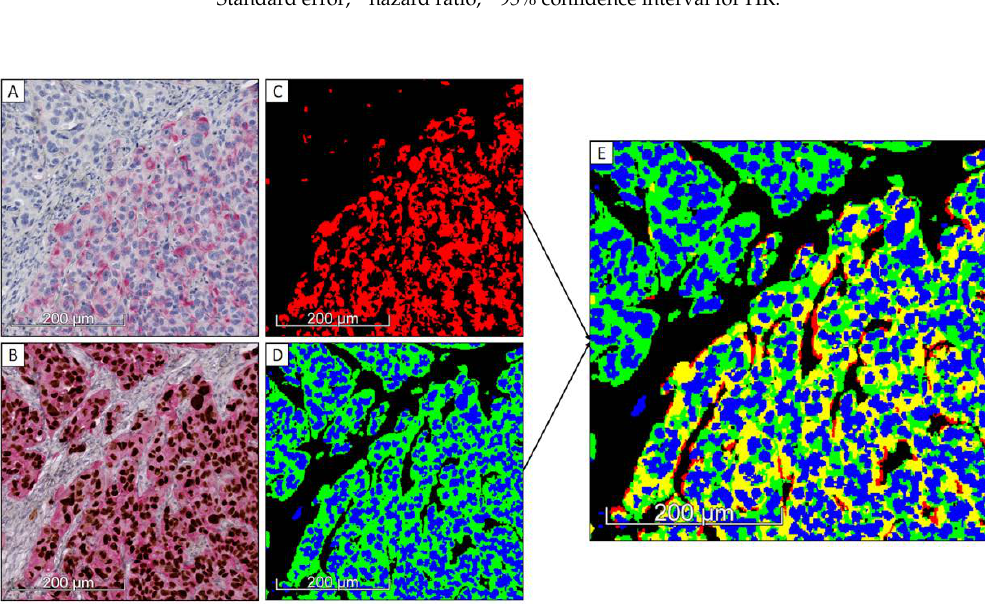
Figure A2. Illustration of the E / M score computation steps adapted for patient-derived xenograft model. Registered images (from the same tissue slide) processed at 10 × magnification (0.906 µ m-side pixel): ( a ) human-specific VIM expression; ( b ) standard double IHC step for evidencing pan-CK expression (red staining) and Ku80 (nuclear marker for identifying human cells in animal model, brown staining); ( c , d ) detection of VIM + (red) and pan-CK + (green) areas, and human cell nuclei (blue); ( e ) detection of pan-CK +/ VIM + area (yellow), pan-CK +/ VIM − area (green), and pan-CK − / VIM + area (red). The hybrid E / M score is computed as the ratio between the yellow area and the sum of the yellow and green areas. This methodology was recently applied in a study submitted for publication.